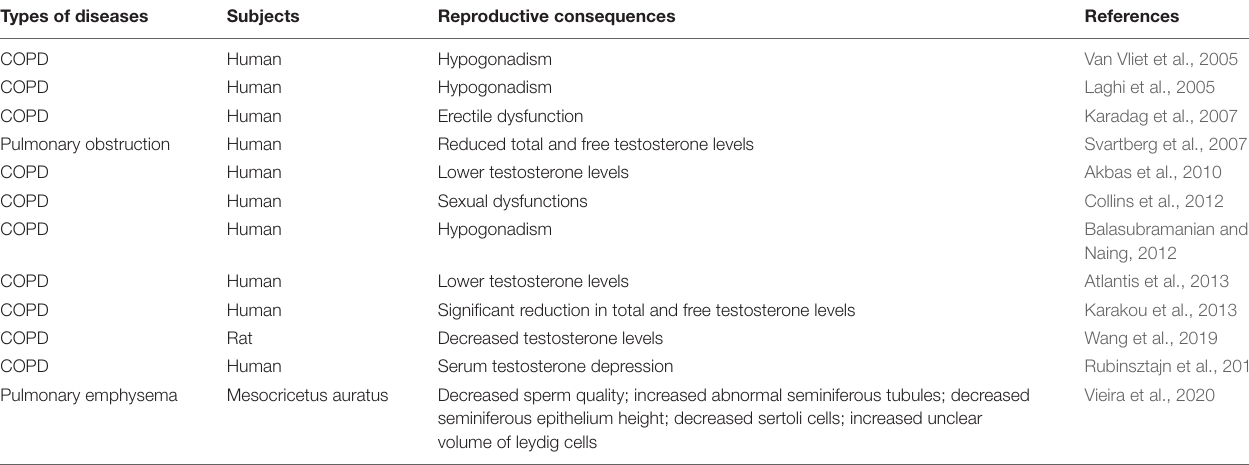
TABLE 3 | Summary of the studies reporting the reproductive consequences of chronic lung diseases.